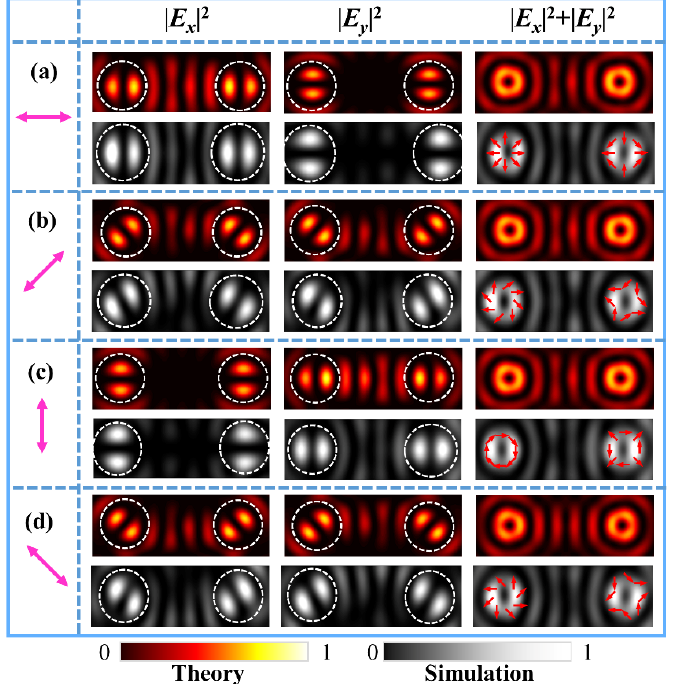
Figure 3. Theoretical and simulated intensity patterns of different FVBs of orders l l = 1 (VBs) and l r = −1 (π − VBs) in the dual channels under the illuminating light polarizing at 0° ( a ), 45° ( b ), 90° ( c ), and 135° ( d ), respectively. The magenta double arrows represent the polarization direction of illumination light.